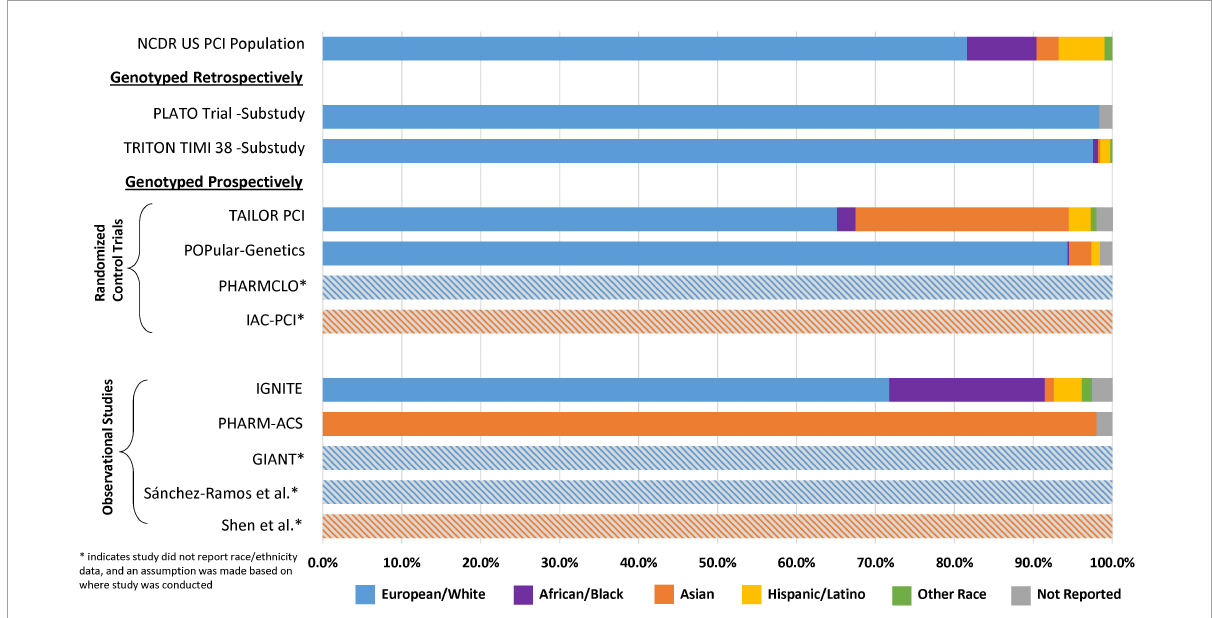
FIGURE2 Reported race and ethnicity data from selected major clinical outcome trials utilizing clopidogrel and in which CYP2C19 status was reported. This figure compares the relative percent distribution of reported race and ethnicity from study participants included major retrospective and prospective clinical outcome studies of CYP2C19 genotype-guided antiplatelet therapy. ∗ Studies with the gray hatched bars did not report race and ethnicity data, and an assumption about the population demographics was made based on the study site locations described in Table 1 (Europe or China). For reference, the demographic characteristics of each study were compared to data obtained from the National Cardiovascular Data Registry (NCDR): the race and ethnicity distribution of patients who underwent PCI in the U.S. was 86.5% White